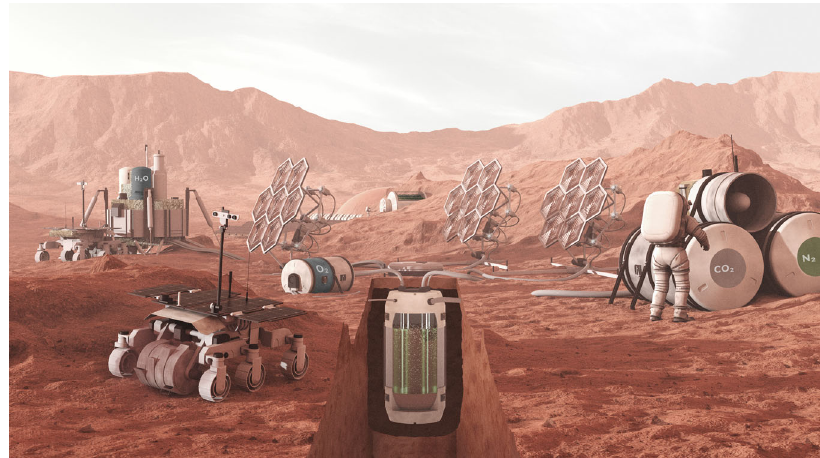
Fig. 1 Artistic representation of a system where diazotrophic, rock-leaching cyanobacteria are grown using materials available on Mars. In that system, the necessary water is mined from the ground 49 ; carbon and nitrogen are sourced from the atmosphere and provided at a low (though higher than Mars-ambient) pressure 7 ; and mineral nutrients are obtained from the regolith 7,8,10,50 . Lighting is provided as collected sunlight supplemented, when needed, with LEDs. Cyanobacteria could produce consumables such as O 2 and dietary proteins, but also support the growth of secondary producers 9 – which, in turn, could generate products ranging from food to materials to pharmaceuticals to fuels. Here, cyanobacteria are depicted in a photobioreactor containing regolith, deposited at the bottom, and a liquid phase stirred by bubbling. The photobioreactor is buried to protect cultures, hardware and operators against dust and radiation, as well as to improve thermal stability. The mining of water is represented with an extraction plant on the left, and that of regolith with excavation rovers. A gas separation and compression module, on the right, symbolizes the provision of gases from the Martian atmosphere. Lighting is shown as Fresnel lenses and light guides. Cultivation products are represented by an oxygen storage tank and a greenhouse in the background. Artwork: Joris Wegner, University of the Arts